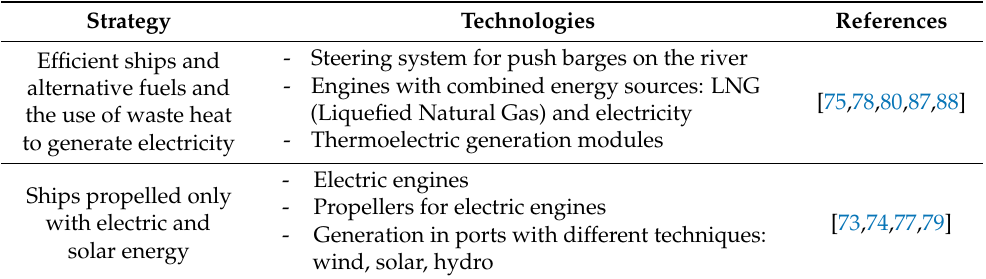
Table 7. Strategies detected in the papers reviewed to face the problems related to emission